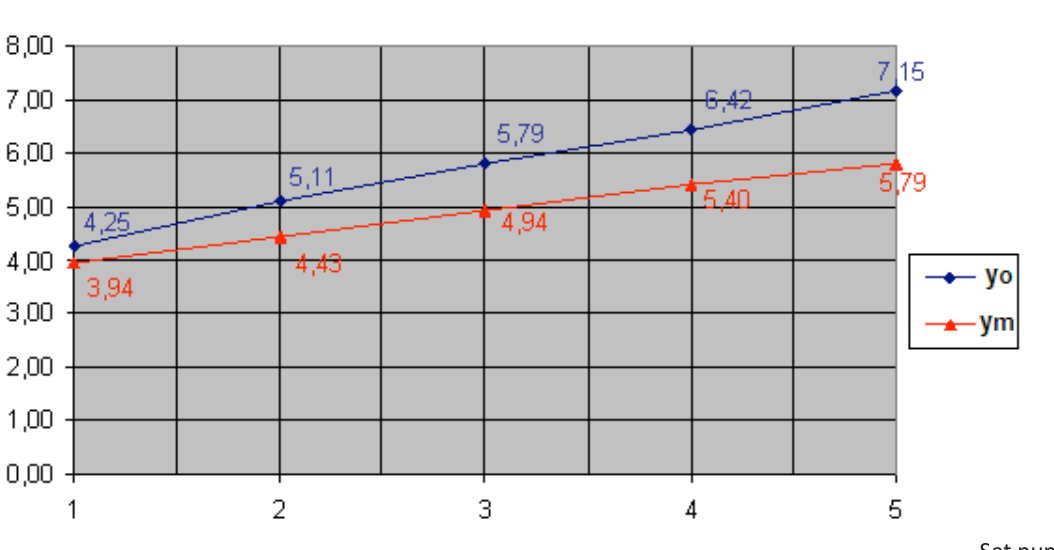
–data for October o